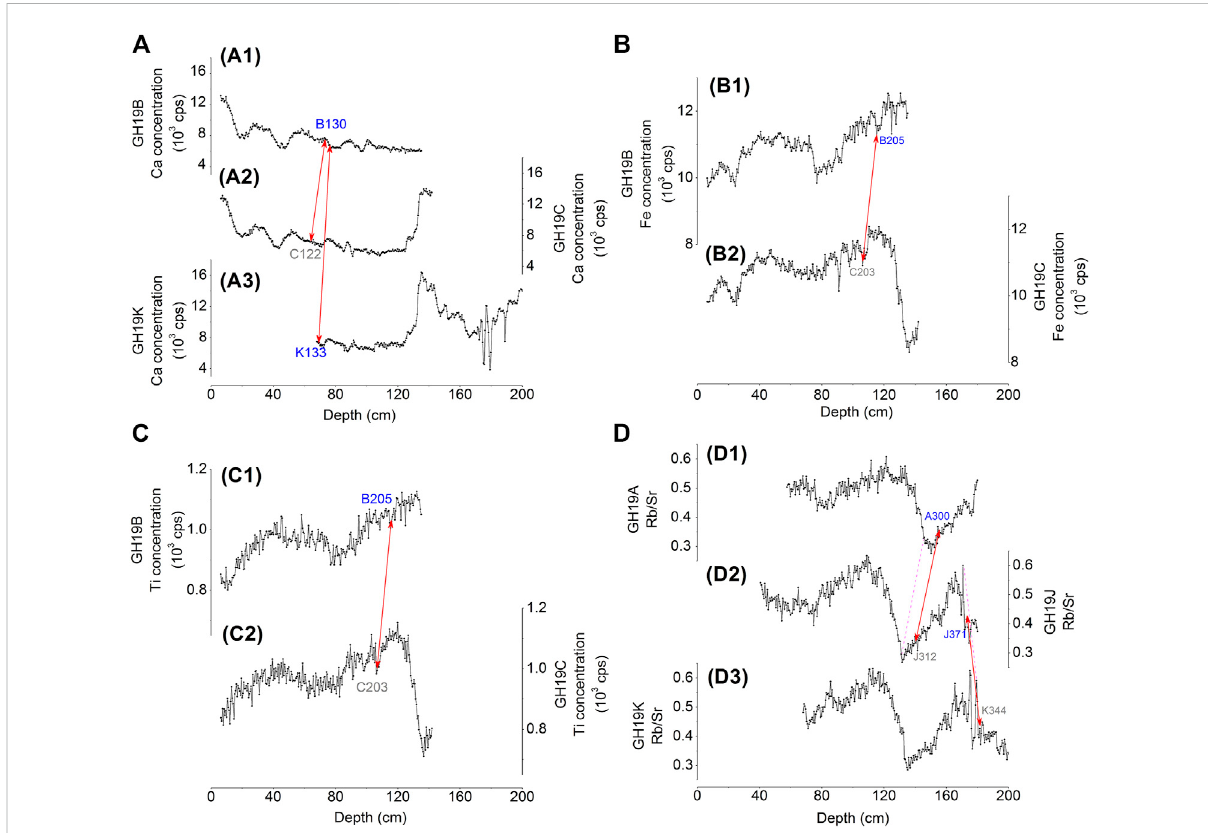
FIGURE 5 (A) Caconcentration-depthplotsforcores (A1) GH19B, (A2) GH19C, (A3) GH19K; (B) Feconcentration-depthplotsof (B1) GH19B, (B2) GH19C; (C) Ticoncentration-depthplots of (C1) GH19B, (C2) GH19C; (D) Rb/Sr-depth plotsof (D1) GH19A, (D2) GH19J, (D3) GH19K,andtheirchronological correspondence. The blue text indicates samples with absolute dating data, the grey text indicates samples with relative dating data, and red double arrows indicate the correspondence between the dating points; the magenta dashed line indicates the corresponding in fl ection point of the sign. The reason why the proxies of the top of GH19 A/J/K were not measured was introduced in Section